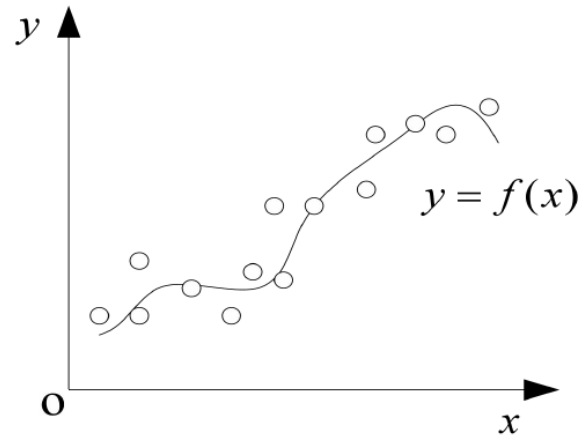
Figure 4. Regression function.